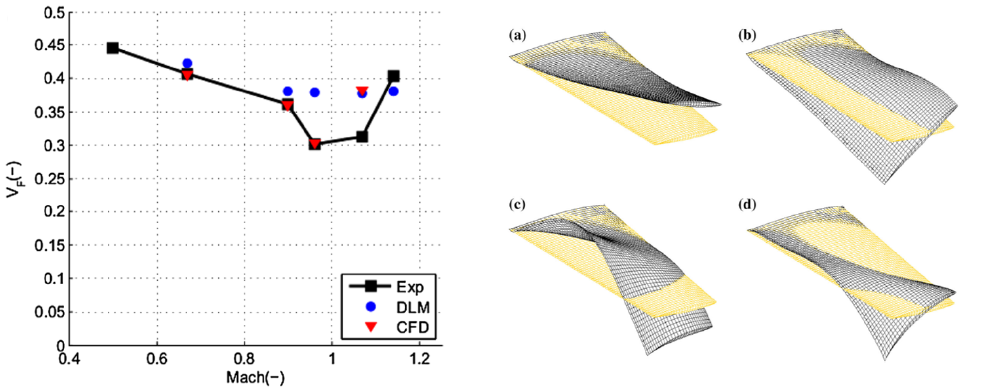
Figure 8. ( Left ): Flutter velocity results for the AGARD 445.6 case. ( Right ): First ( a ), second ( b ), third ( c ) and fourth ( d ) AGARD 445.6 wing modal shape [52].